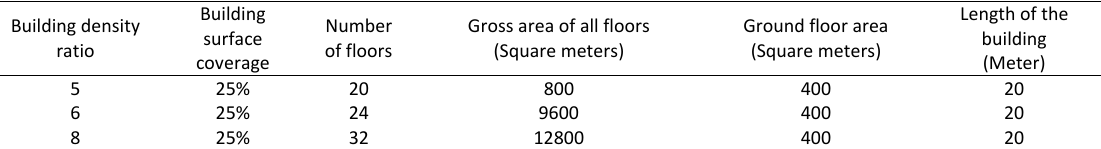
Table 4: Proposed classes for optimizing energy consumption for sheet formwork in Khorramshahr Building density ratio